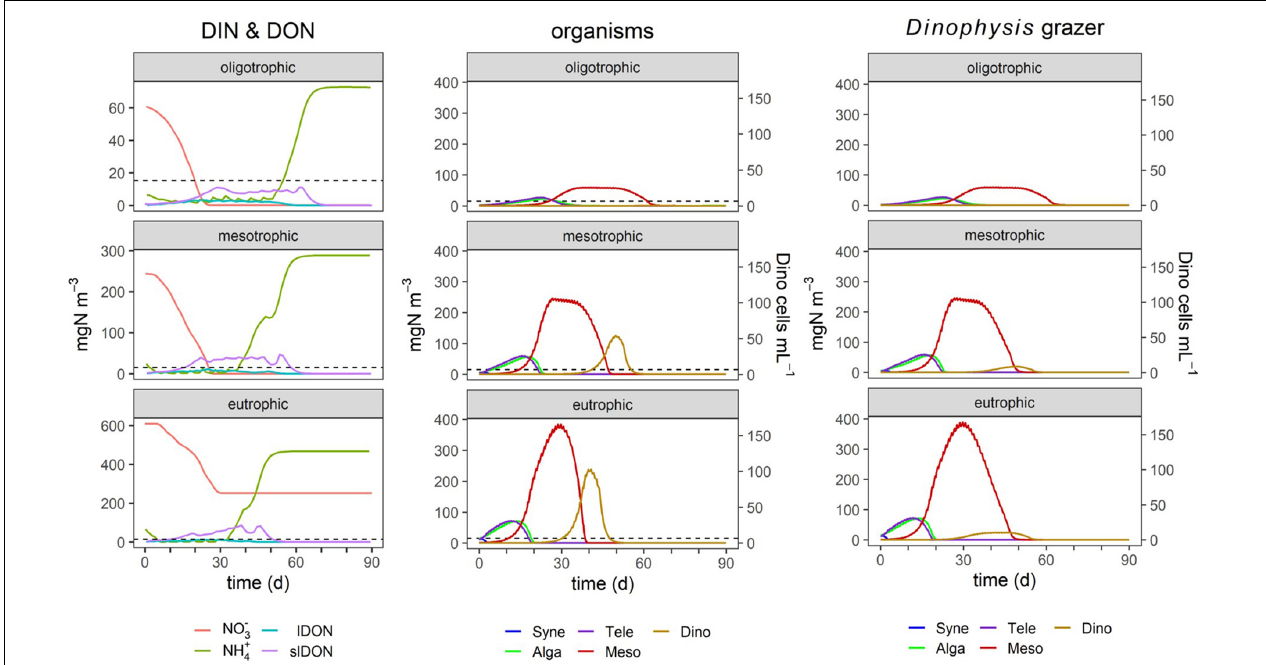
FIGURE 4 | Effect of nutrient loading on TMD dynamics. The nitrogen concentration loads were 70 mgN m − 3 (oligotrophic), 280 mgN m − 3 (mesotrophic), and 700 mgN m − 3 (eutrophic). Cell numbers for Dinophysis (secondary y -axis) were transformed from nitrogen biomass assuming the cell size of D. acuminata ; see the “Materials and Methods” section. Legend identifications are as follows: Syne, Synechococcus sp.; Alga, generic phytoplankton; Tele, Teleaulax ; Meso, Mesodinium ; Dino, Dinophysis ; lDON, labile DON; slDON, semi-labile DON. The dashed line indicates the total nitrogen loading under oligotrophic conditions as a reference for the other simulations that have a different y -axis scale. The column labeled “ Dinophysis grazer” shows the same simulations as the column “organisms” except now with the closure grazing function applied to Dinophysis . The complete test conditions are listed in Table 4